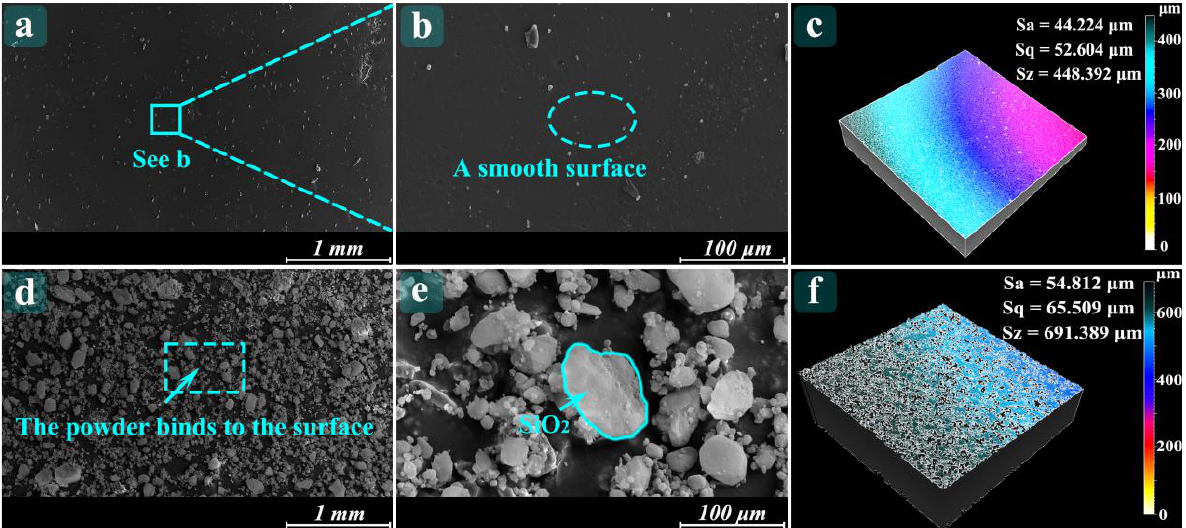
Figure 6. ( a ) Shows the SEM image of sample A; ( b ) is an enlarged view of the box area of ( a ); ( c ) is the interferometric three-dimensional topography cloud image of sample A; ( d ) is the scanning